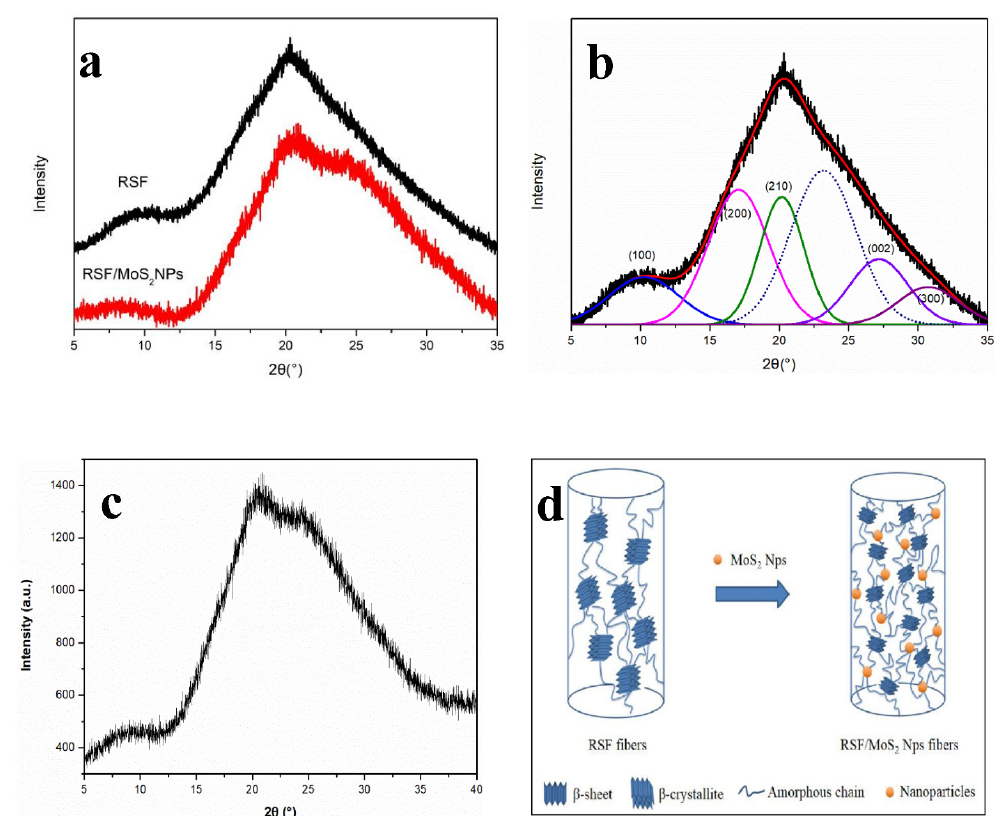
Figure 4. ( a ) XRD pattern of RSF fibers and 2 wt% RSF/MoS 2 NPs hybrid fibers; ( b ) XRD pattern deconvolution of RSF fibers; ( c ) initial XRD pattern of 2 wt% RSF/MoS 2 NPs hybrid fibers; ( d ) schematic illustration of structural change of RSF fibers and RSF/MoS 2 NPs hybrid fibers.